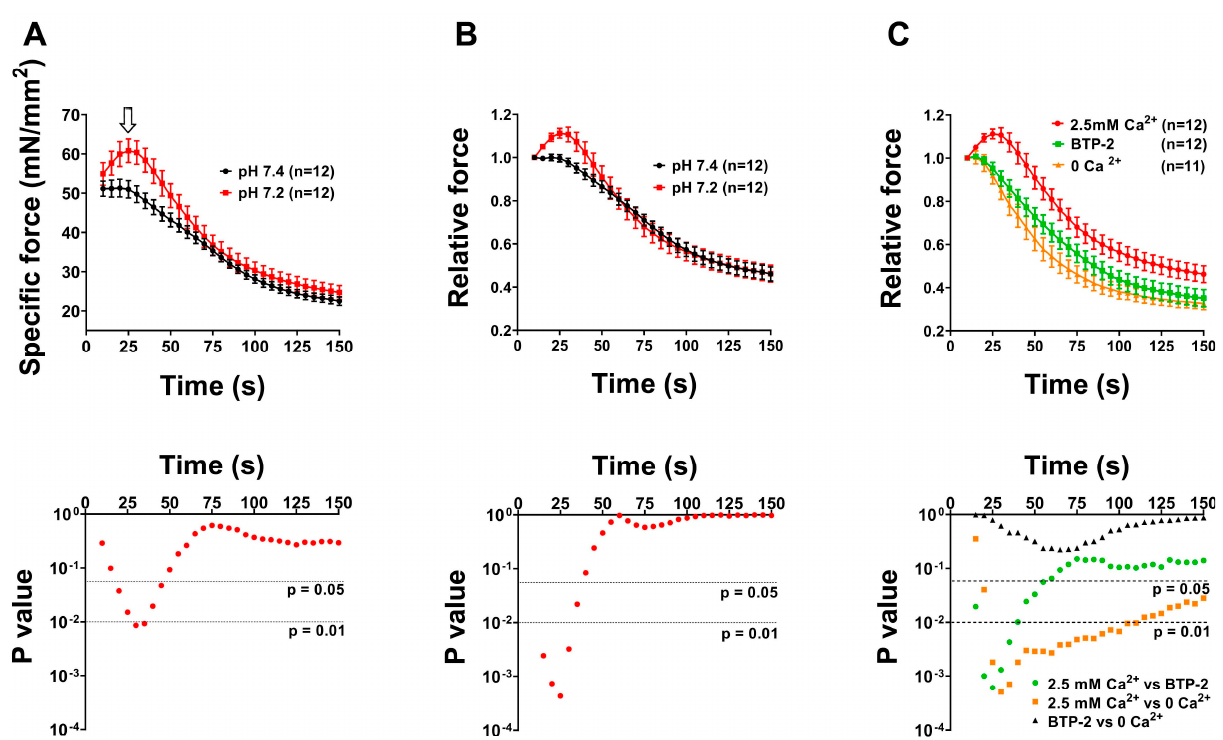
Figure 7. Contractile force of EDL muscle after the ex vivo exercise protocol at pH 7.4 vs. 7.2 (25 °C) .( A ) Time course of average specific force decay during 30 consecutive frequency stimulus trains (60 Hz, 1 s, every 5 s), normalized to CSA, in EDL muscles previously ex vivo exercised at pH 7.4 or at pH 7.2. Arrow points to the bump-phase, previously characterized in two papers by Michelucci and colleagues as the phase of activation of SOCE [81,82]. ( B ) Data represented as relative force (normalized to the first stimulus train). ( C ) Time course of average relative force decay (in presence or absence of 2.5 mM extracellular Ca 2+ and in a solution supplemented with 10 µM BTP-2) in EDL muscles previously subjected to the ex vivo protocol at pH 7.2. Data are shown as mean ± SEM. Bottom panels represent semi-log plot showing results of multiple unpaired t test (first two panels) or two-way repeated measures ANOVA followed by Tukey post hoc test (right panel). n = number of EDL muscles analyzed for each condition.